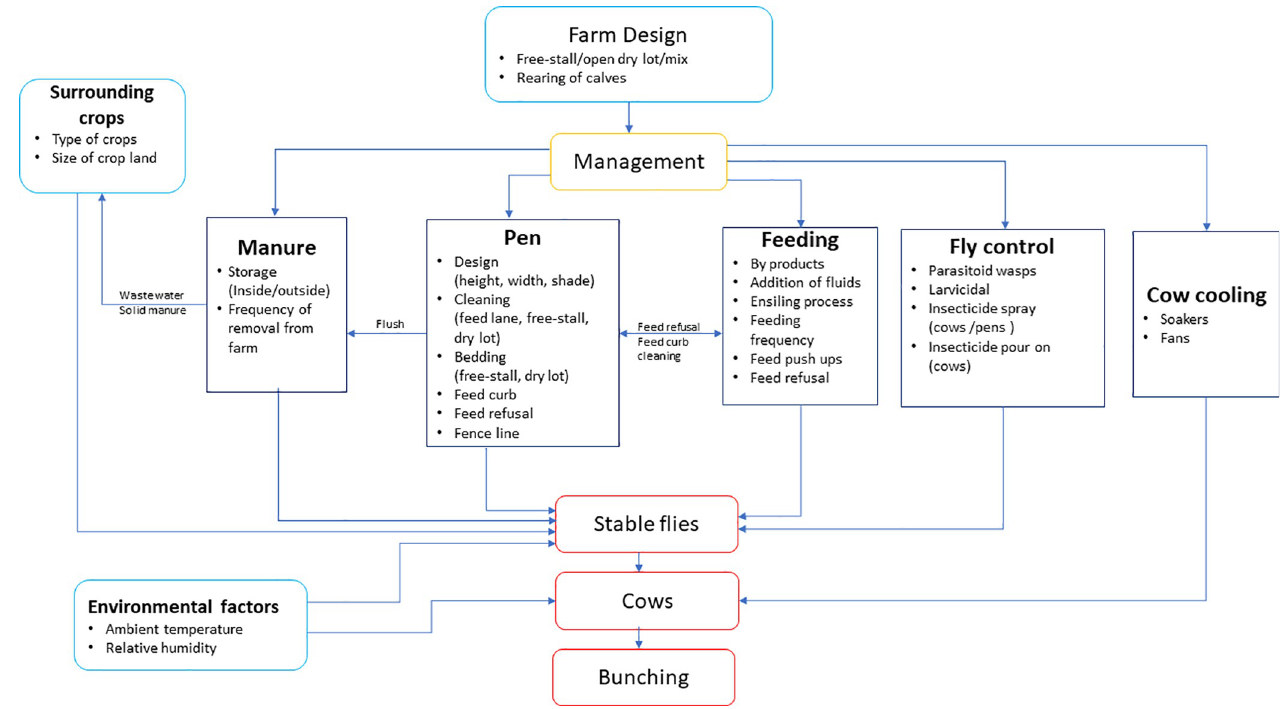
Fig 1. Causal diagram for the explanatory variables that guides the statistical models.